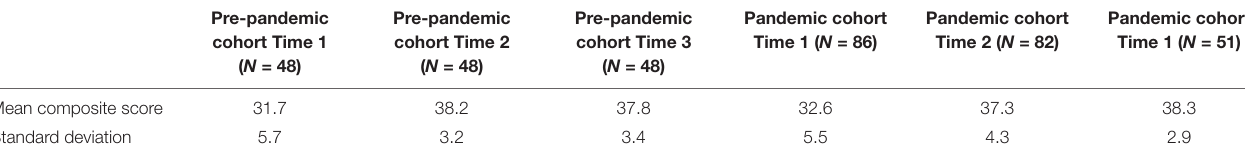
TABLE 8 | Mean composite scores for fixed ability pre-pandemic cohort (Spring 2020/Fall 2019) and Pandemic Cohort (Fall 2019/Spring